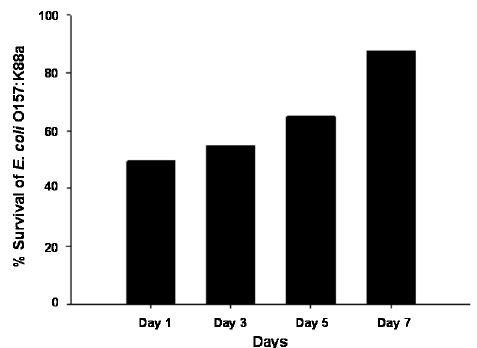
Figure 8. Survival of cells obtained from different colony ages of E. coli O157:K88a exposed to 10 ppm ozone concentration for 2 min. After ozone exposure, the culture plates were maintained at 37 °C for seven